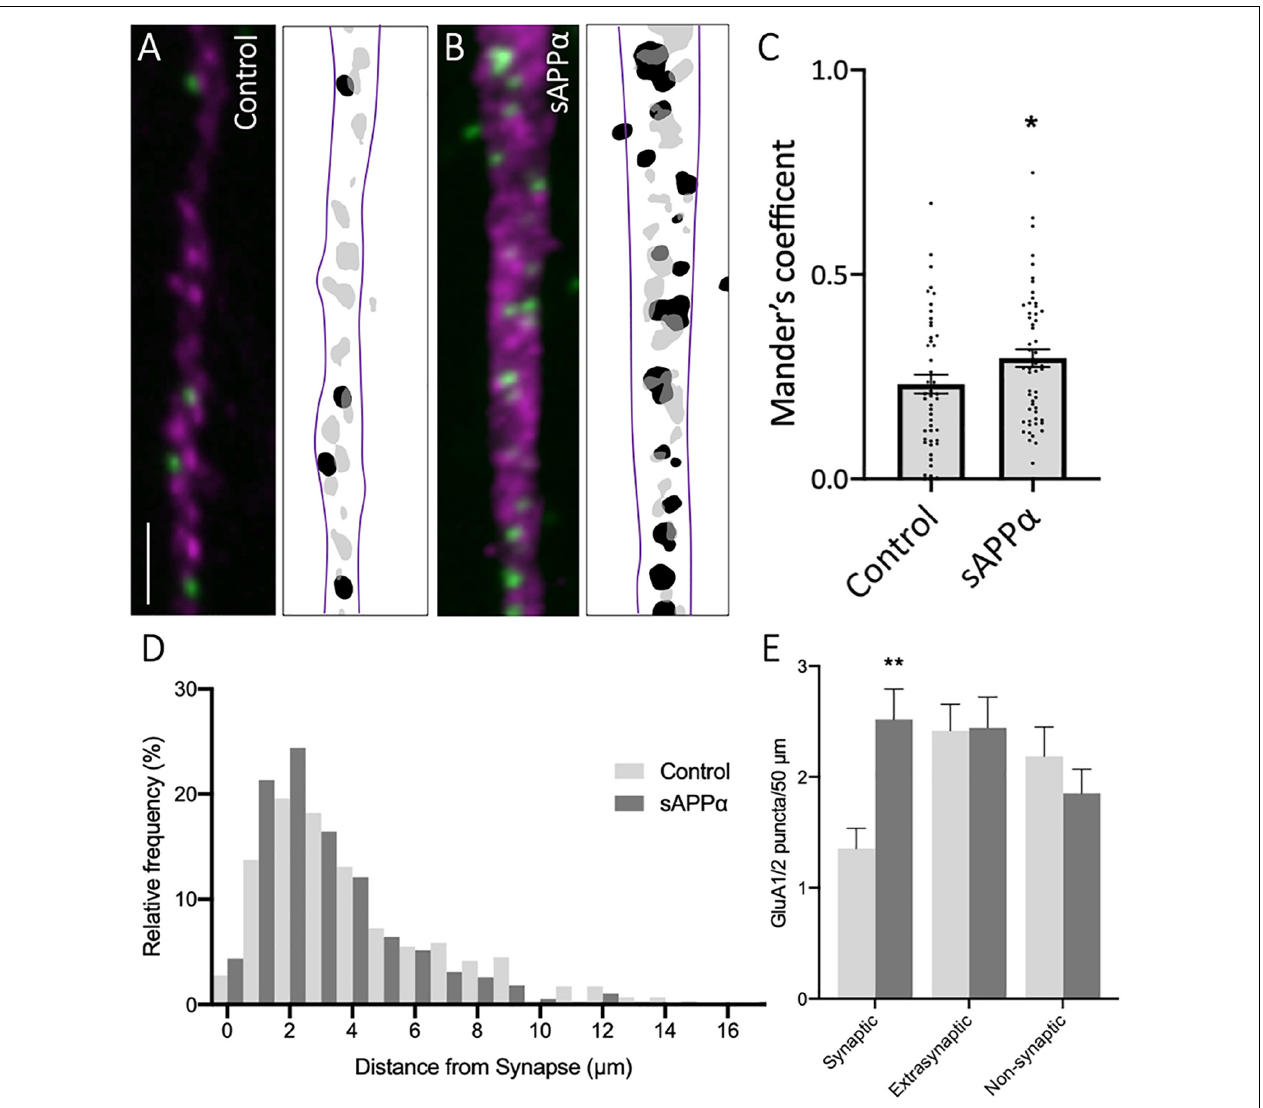
FIGURE 7 | Secreted amyloid precursor protein-alpha enhances GluA1/2 AMPARs at synapses. Representative images showing cell-surface GluA1/2 AMPARs in (A) control and (B) sAPP α -treated conditions Representative images show dendrites (50 µ m; synapsin-1, (cid:4) ; GluA1/2, (cid:4) ). Scale bar = 10 µ m. (C) sAPP α treatment (1 nM, 2 h) showed a significant increase in Mander’s overlap coefficient ( n = 20 cells, 49–54 dendrites). Significance was assessed by unpaired t -test. (D) Frequency histogram of the distribution of GluA1/2 puncta in relevance to synapsin-1 immunofluorescence. Distances were calculated for individual PLA puncta with respect to the closest synapsin-1 center of mass. Synaptic PLA showed overlapping centers within 0–2 µ m, puncta within 2–4 µ m were considered extrasynaptic, and puncta beyond 4 µ m were considered non-synaptic ( n = 49–54 dendrites, 291–389 puncta). (E) Quantification of GluA1/2 puncta abundance at the synaptic,